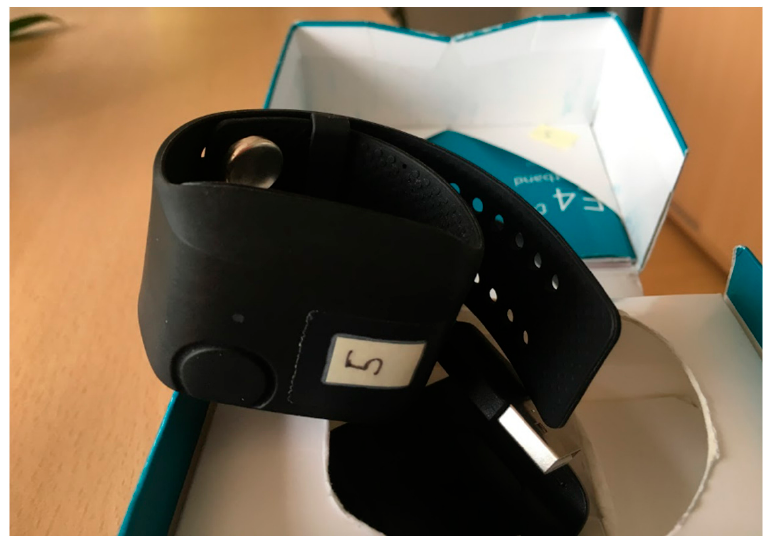
Figure 4. Wearable sensor collecting psychophysiological parameters during spatial video geonar- rative (SVG). tive